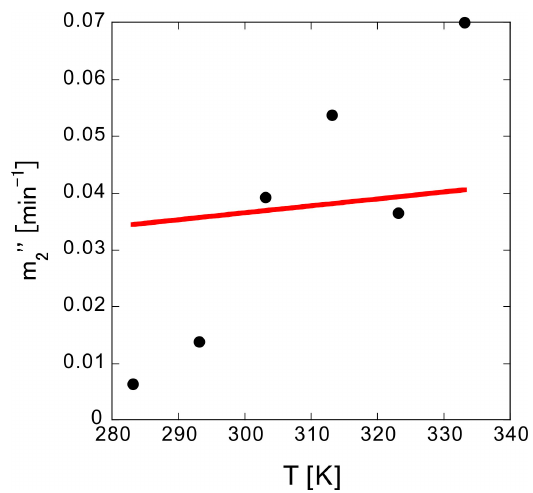
Figure 9. Temperature dependence of true elution rate m 2 ”. The circles are experimental data, while the red solid line is the proportional fitting.